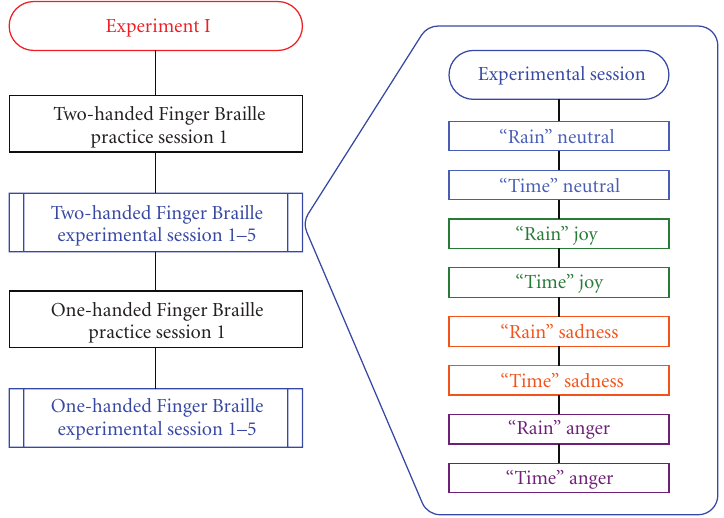
Figure 3: Flow of Experiment